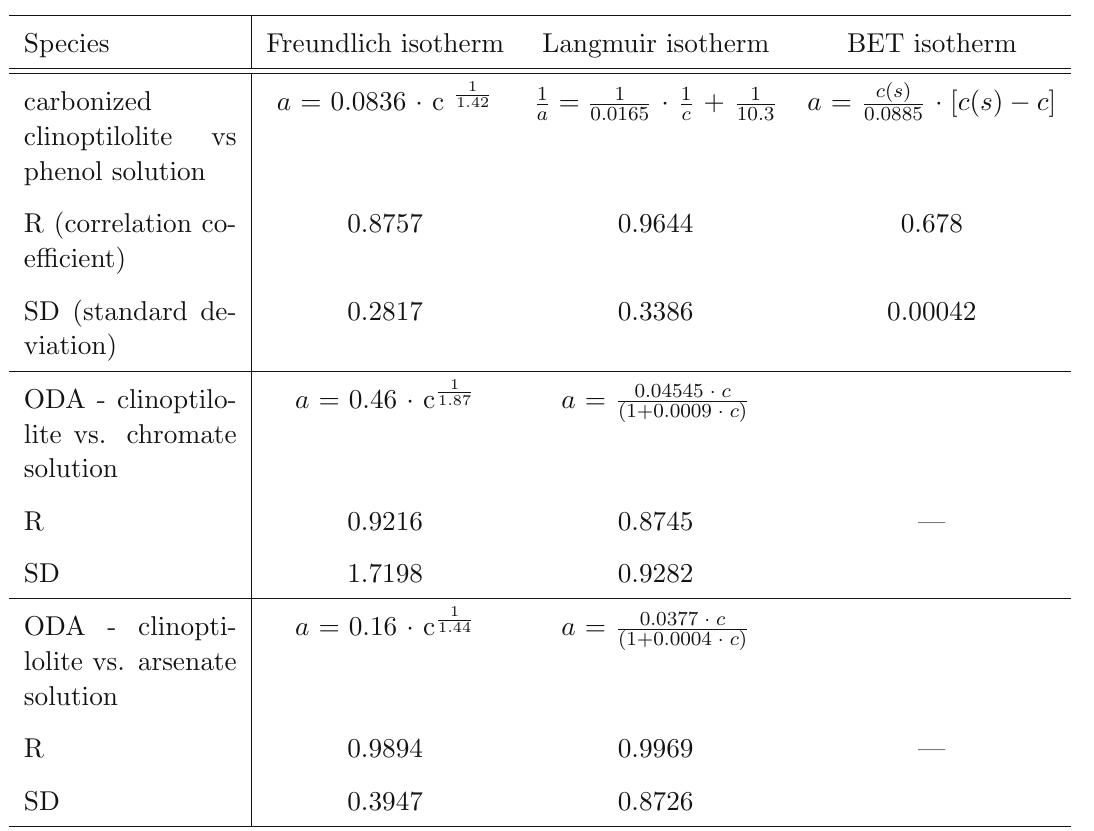
Table 1 Adsorption isotherm data for the systems studied: aqueous phenol solution vs. carbonised clinoptilolite and aqueous arsenate or chromate solutions vs. ODA hydropho- bized